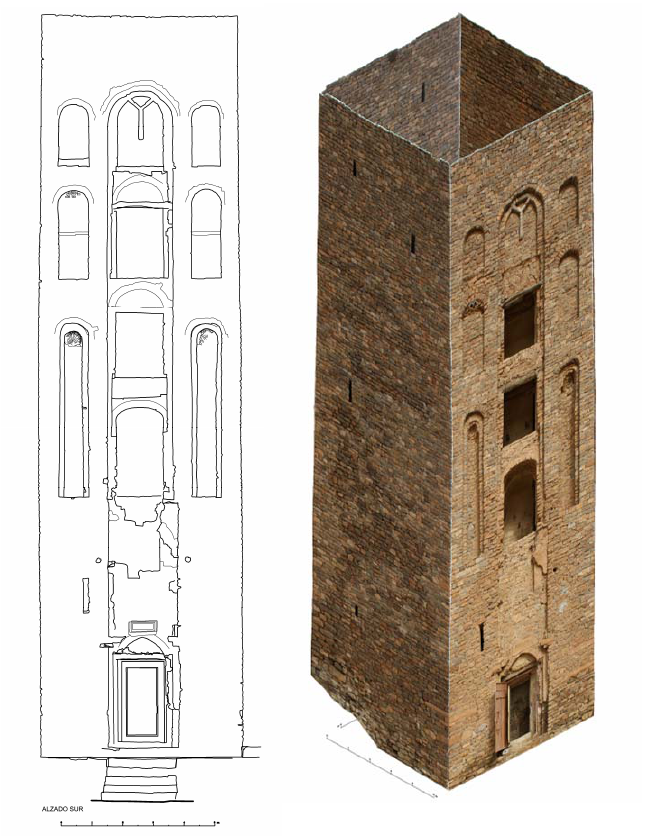
Figure 10. Elevation and photographic 3D model of the minaret of the Qala of Beni